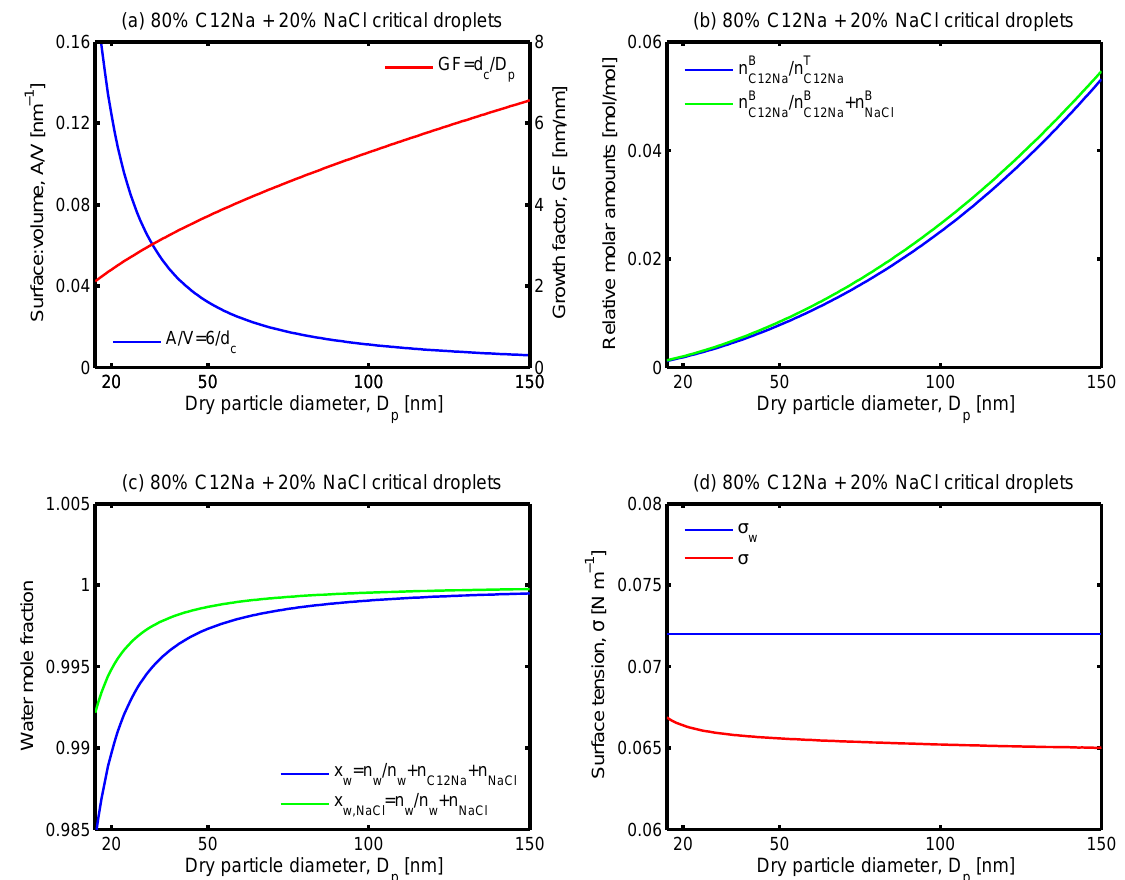
Fig. 1. Selected properties, predicted at the point of droplet activation, for spherical dry particles comprising 80% by mass of surfactant (sodium dodecanoate, C12Na) mixed with sodium chloride (NaCl): (a) diameter growth factor (GF) and droplet surface-area-to-bulk-volume ratio ( A / V ), (b) molar fraction of surfactant left in the droplet bulk ( n B ) and molar fraction of total solute in the droplet bulk that is surfactant ( n B = [ n B + n B ] ), (c) bulk-phase water mole fraction ( x B ) and water mole fraction with respect to only NaCl solute ( x B ), (d) droplet surface tension ( (cid:27) ), together with the surface tension of pure water ( (cid:27) w ). Values are presented as functions of dry particle diameter ( D p ) and have been adapted from Prisle et al. (2009).